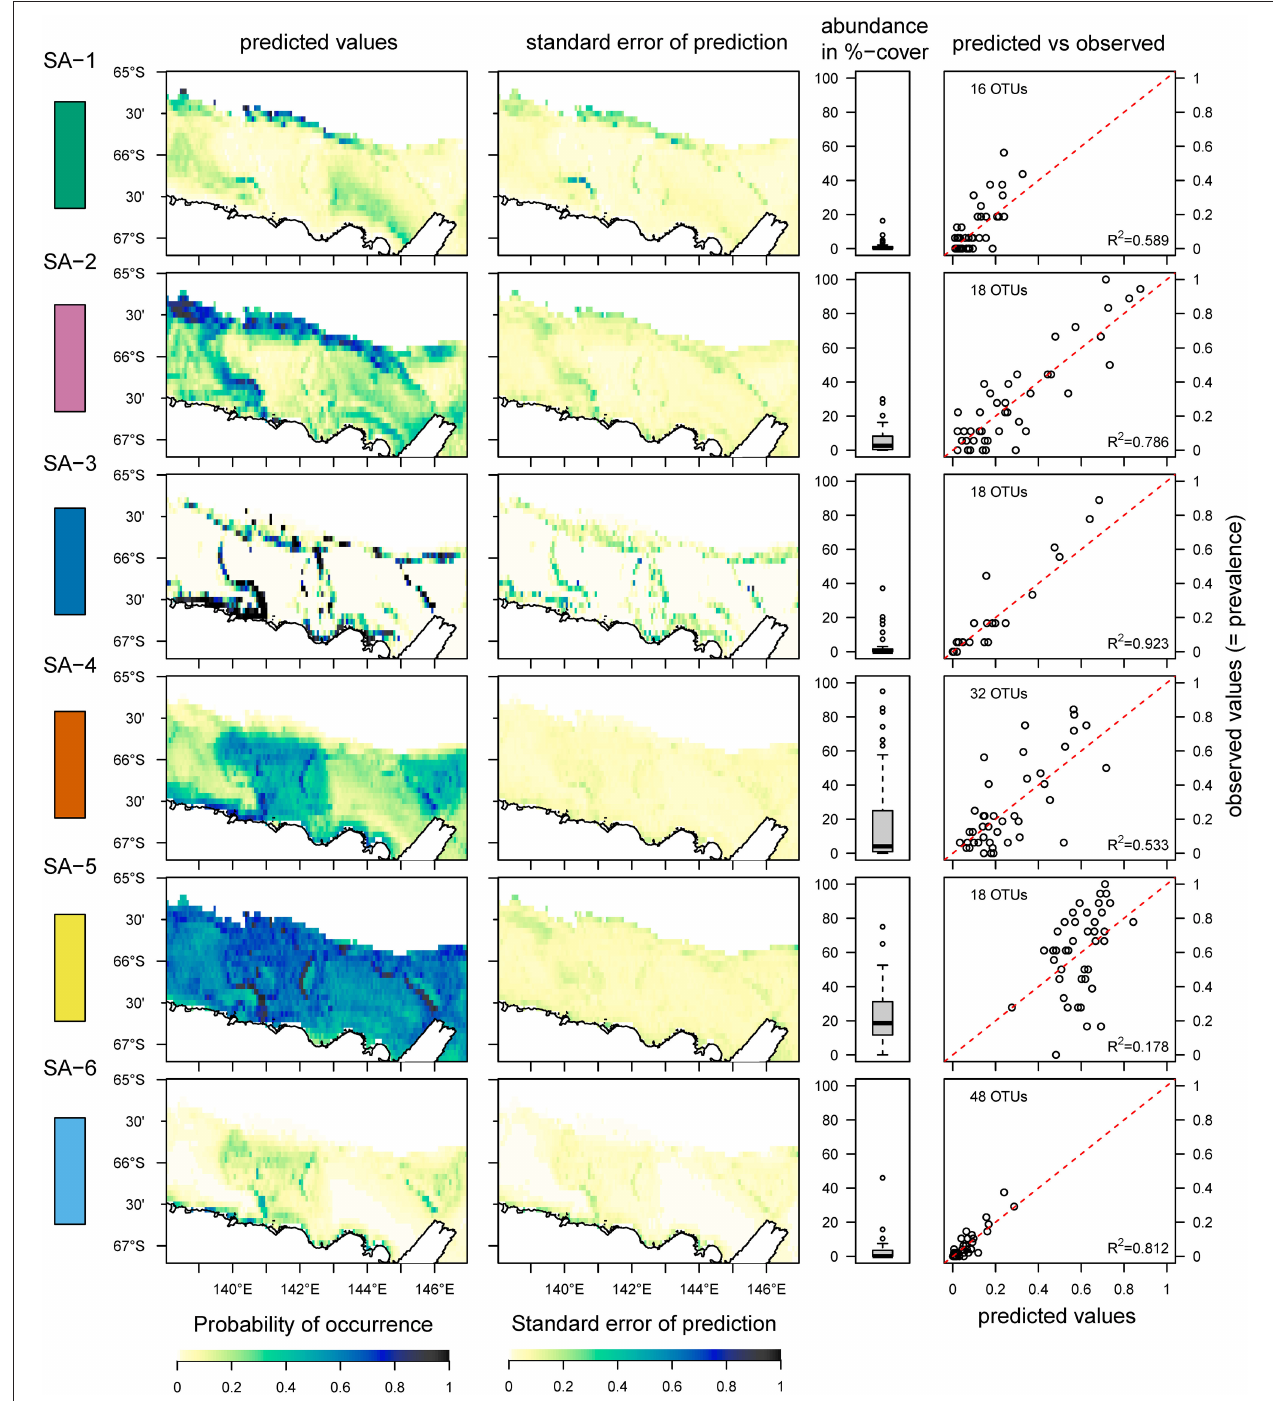
FIGURE 2 | Distribution of six species archetypes (SA 1–6) identified from the OTU-dataset using the species archetype analysis, the standard error of the prediction, the total abundance of all OTUs combined within each SA and the relationship between predicted and observed values. A color-code is added on the left side of the graphs for helping to compare this figure with Figures 3 , 4 . The red dotted line indicates the 1:1 line between predicted and observed values; the R 2 -value is for a linear regression between observed and predicted values. The predictions are based on data from 41 sites, and the area under the Mertz Glacier Tongue is excluded from the